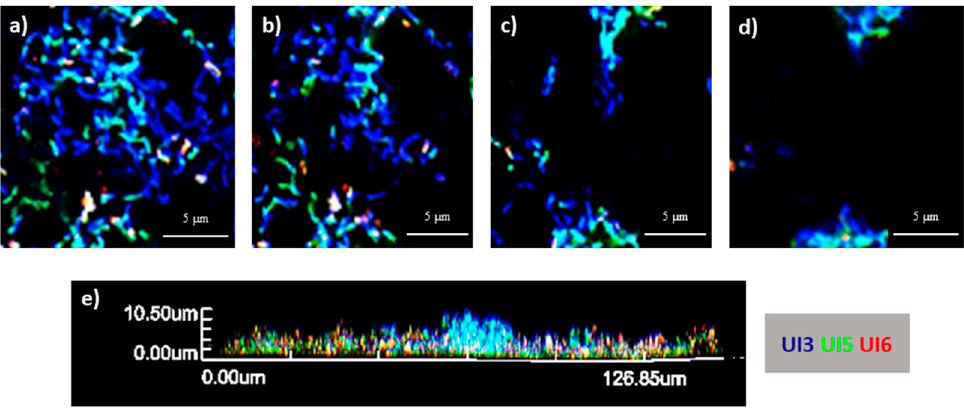
Figure 5. Three-dimensional organization of 6 h-aged biofilm formed in AUM and in polystyrene coupons by a consortium of three E. coli strains (UI3—blue, UI5—green and UI6—red). ( a ) Examples of CLSM (confocal laser scanning microscopy) images obtained of the layers within the biofilm at different heights ( a = 0 µm; b = 0.7 µm; c = 2.1 µm; d = 3.5 µm). ( e ) Cross-section of the biofilm.